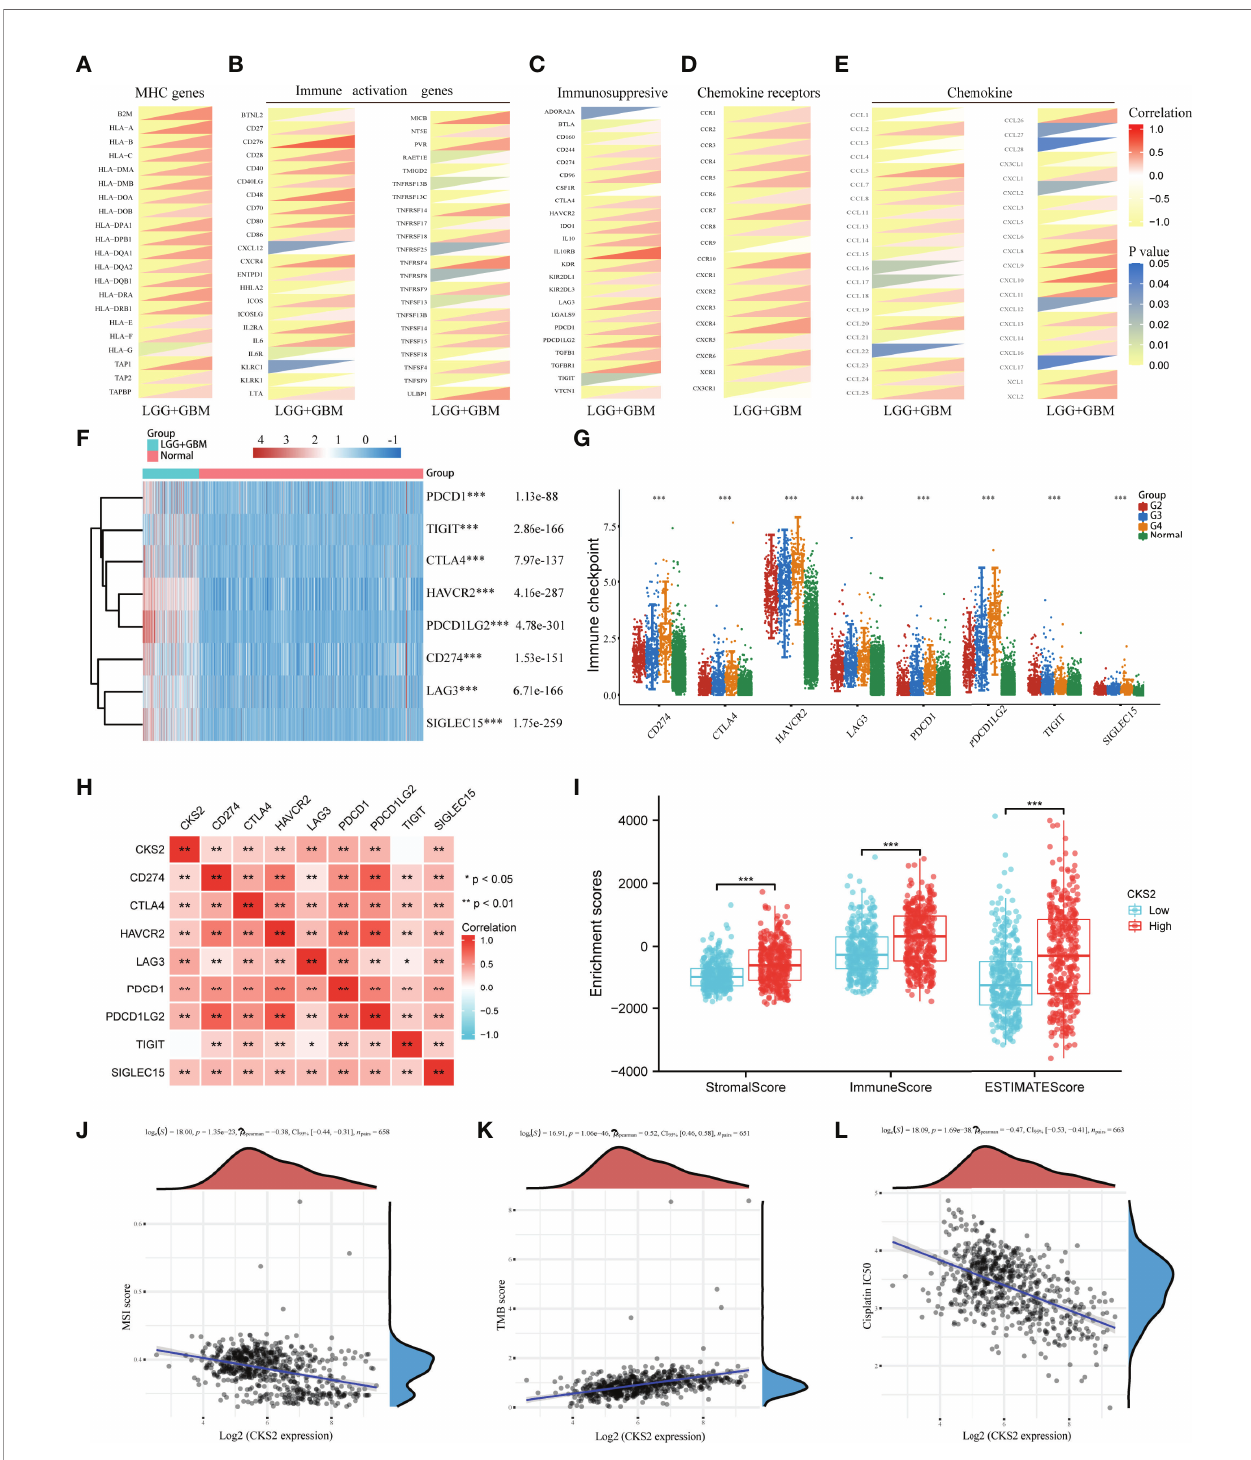
FIGURE 8 | StudyontheexpressionofCKS2andimmune-relatedgenes,immunescore, andsensitivityto chemotherapy. CKS2 isco-expressedwith (A) MHC, (B) immune activation, (C) immunosuppression, (D) chemokinereceptors,and (E) chemokinegenes. (F,G) DifferentialexpressionofimmunecheckpointsinnormalandLGG_GBM patients. (H) CorrelationofCKS2withimmunecheckpointsinLGG_GBM. (I) CorrelationofCKS2withstromal,immune,andestimatescores. (J,K) ThecorrelationbetweenCKS2 expressionandMSIscore andTMBscore. (L) Correlations CKS2withtheIC50ofchemotherapydrugs.* p <0.05, ** p < 0.01,and*** p <